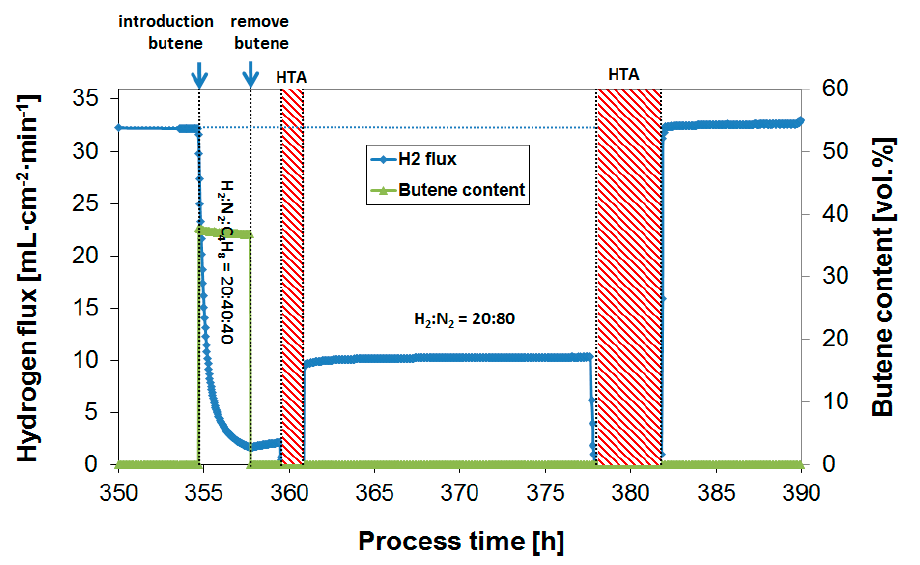
Figure 5. H 2 flux during butylene exposure (40%) to a feed mixture of H 2 :N 2 :C 4 H 10 = 20:40:40, and subsequent air treatments to regenerate the membrane performance. Temperature = 400 °C.